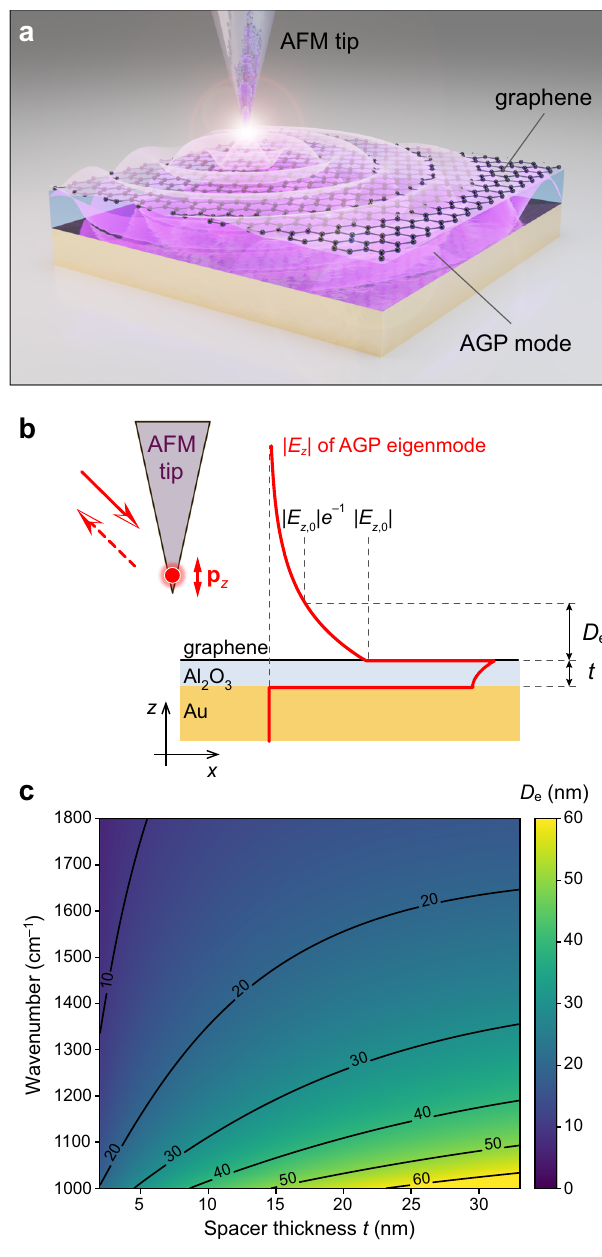
Fig. 1 Plasmon coupling to the AFM tip. a The AFM tip couples to the AGP inside the layered structure via the evanescent fi eld above graphene. b The exponentially decaying z -component of the AGP electric fi eld E z penetrates into the free space above graphene by distance D e and couples to the AFM tip that acts as a z -oriented electric dipole p z . c Penetration depth of | E z | as a function of excitation frequency and spacer thickness calculated for graphene E F = − 0.5